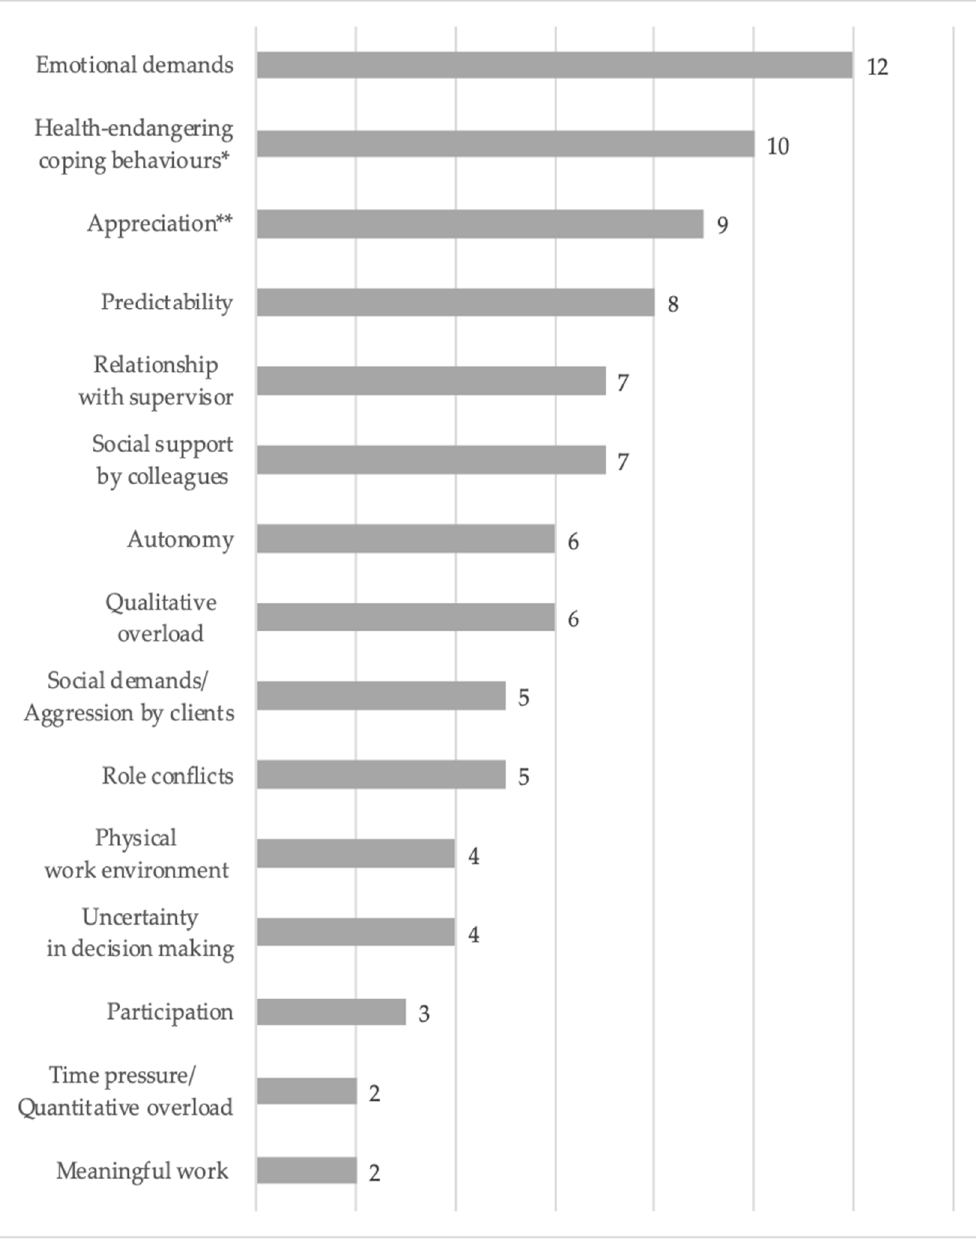
Figure 2. Prioritisation of issues at the focus group